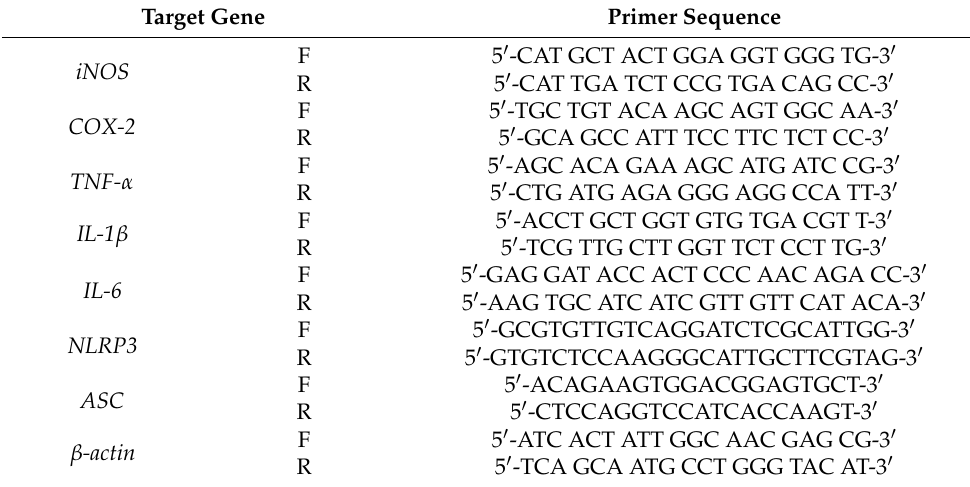
Table 2. The list of primer sequences used in the RT-qPCR analyses. Target Gene Primer